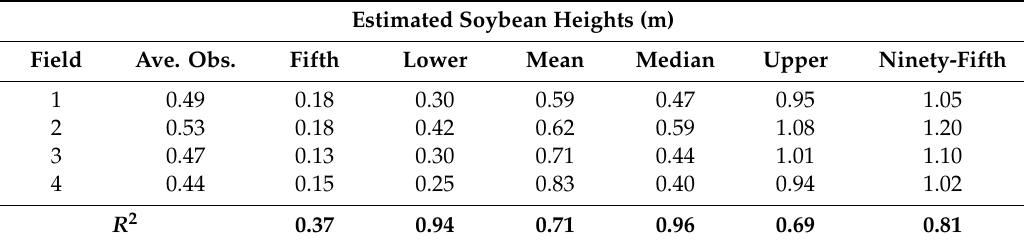
Table 4. Estimated soybean heights measured in the field. Median estimated values provided maximum description ( R 2 = 0.96) of observed